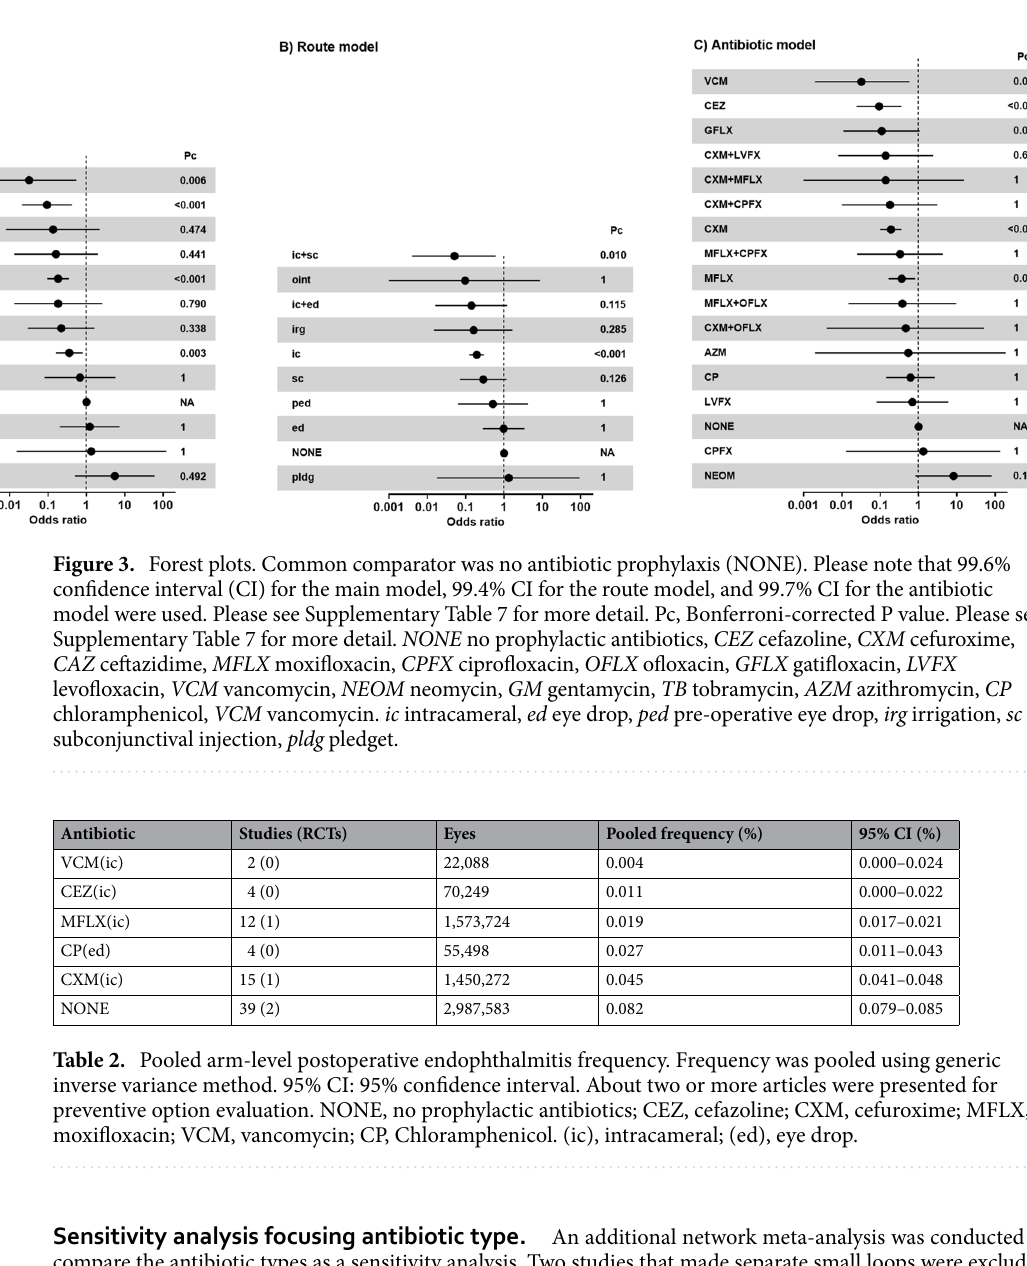
Table 2. Pooled arm-level postoperative endophthalmitis frequency. Frequency was pooled using generic inverse variance method. 95% CI: 95% confidence interval. About two or more articles were presented for preventive option evaluation. NONE, no prophylactic antibiotics; CEZ, cefazoline; CXM, cefuroxime; MFLX, moxifloxacin; VCM, vancomycin; CP, Chloramphenicol. (ic), intracameral; (ed), eye drop.